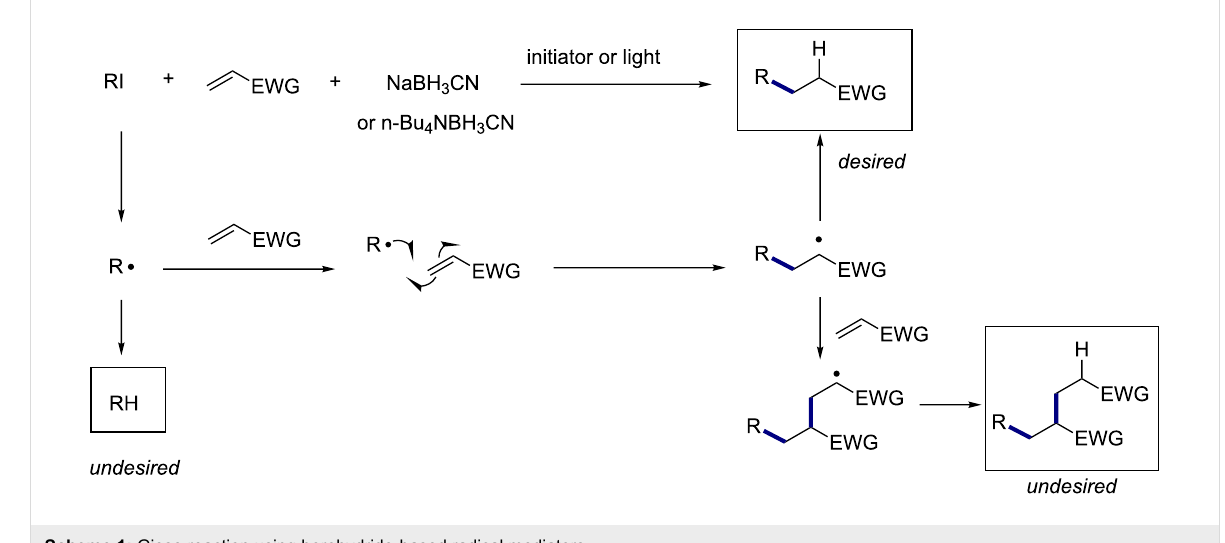
Scheme 1: Giese reaction using borohydride-based radical mediators.